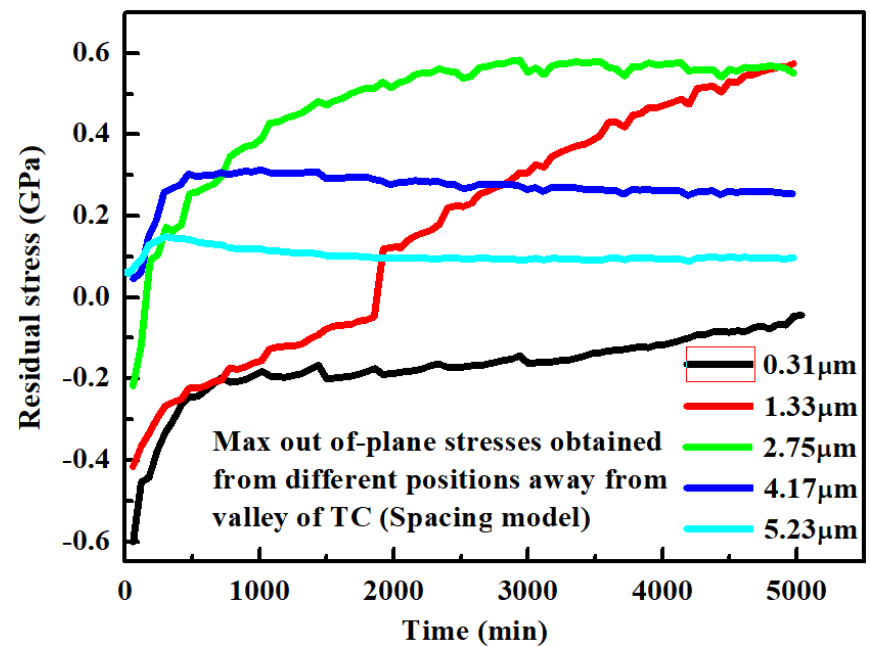
Figure 37. Out-of-plane residual cooling stresses calculated at the valley of the TC as a function of time at several positions using the transitional roughness model.